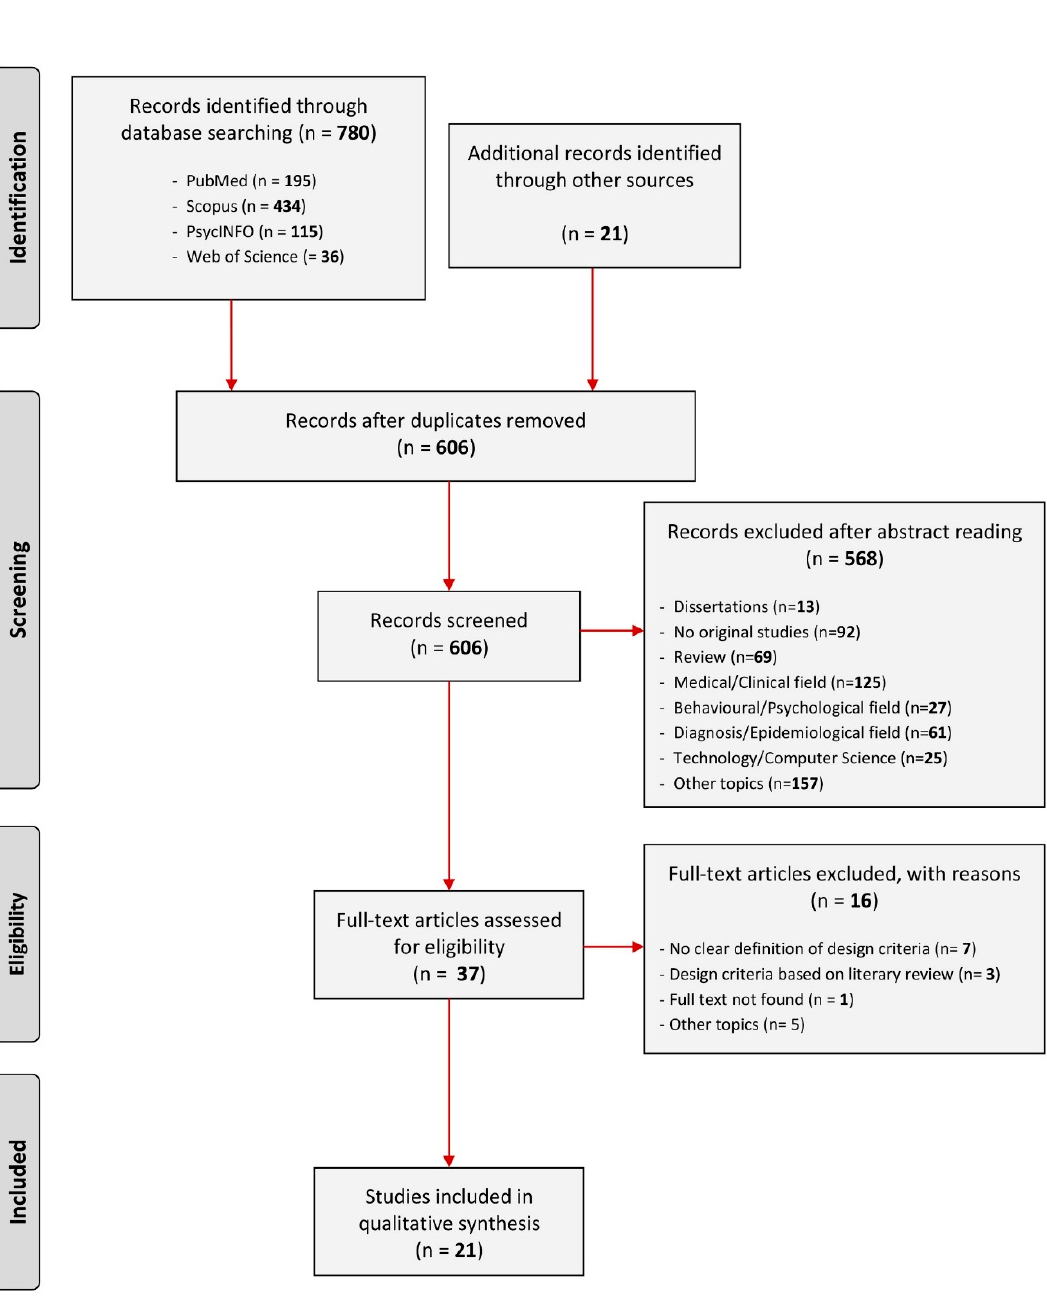
Figure 1. The studies selection process is reported according to the Preferred Reporting Items for Systematic Reviews and Meta-Analyses (PRISMA) flowchart model [29].